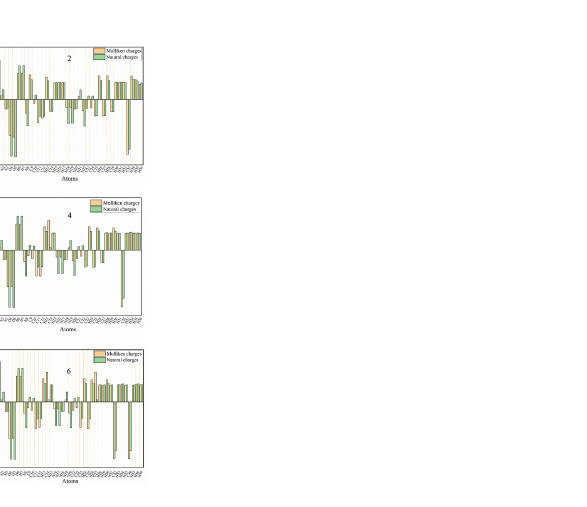
FIGURE 6 | Distribution of calculated Mulliken charges and natural atomic charges for compounds 1, 2, 3, 4, 5 and 6.